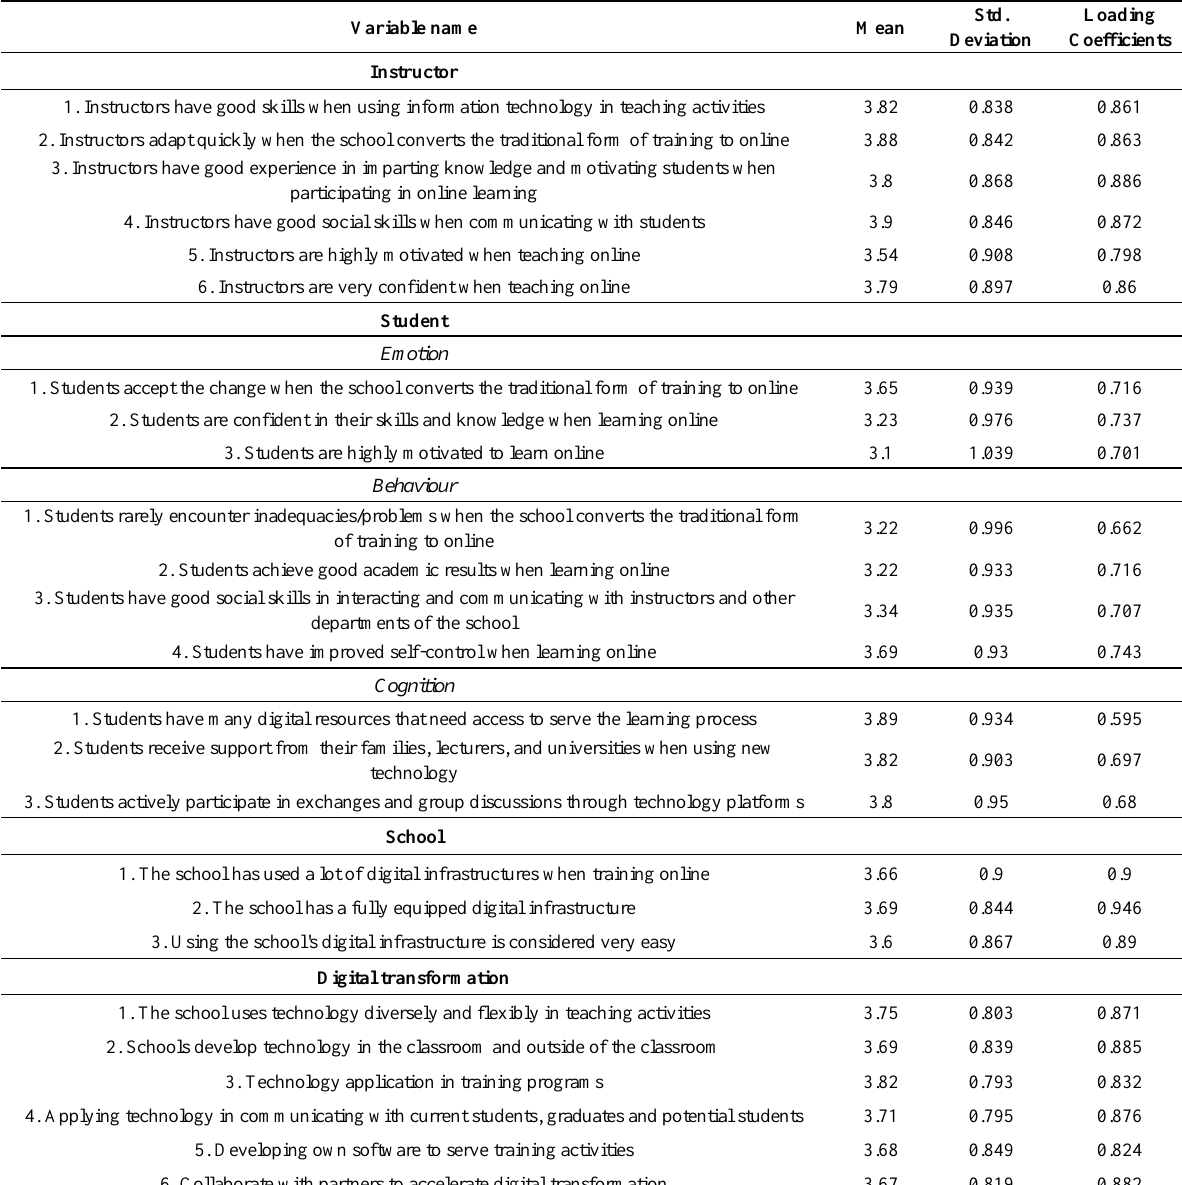
Table 2. Descriptive statistics of variables included in the research